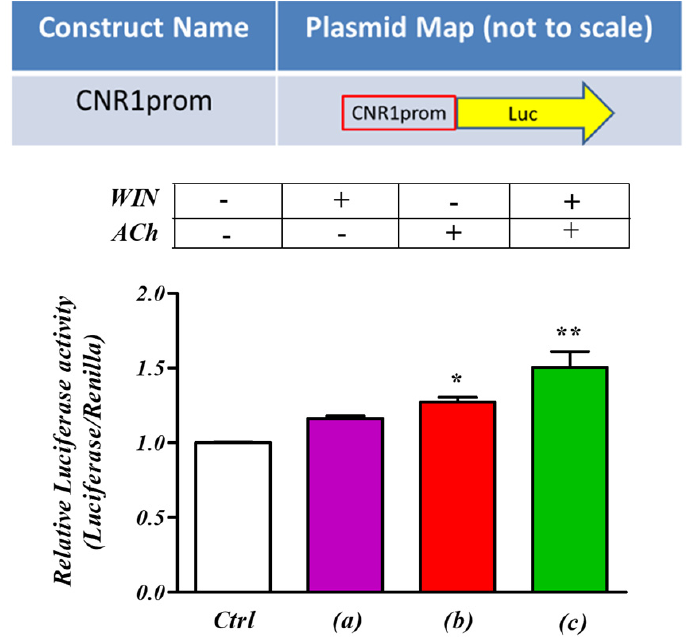
Figure 6. ACh ‘priming’ sensitizes the proximal promoter region of CNR1. Diagrammatic repre- sentation of the luciferase reporter construct used in the experiments with human neuroblastoma cells, SH − SY5Y. The cells were transfected with high quality pCNR1 prom reporter plasmid and treated for 30 min with the CB 1 receptor agonist WIN 55,212-22 (WIN, 100 nM, ( a )), or the M 3 receptor agonist acetylcholine (ACh, 1 µ M, ( b )), or with a combination of both ( c ). Following stimulation of transfected SH − SY5Y cells with WIN 55,212-2, no significant change was seen. However, after ACh treatment, a significant increase in luciferase expression was observed. A greater magnitude of CNR1 promoter activity was observed when the transfected cells were stimulated with both CB 1 (WIN) and M 3 (ACh) receptor agonists. * p < 0.05 vs. Ctrl, ** p < 0.01 vs. Ctrl. One-way analysis of variance followed by Multiple Comparison test, with Bonferroni’s correction ( n =